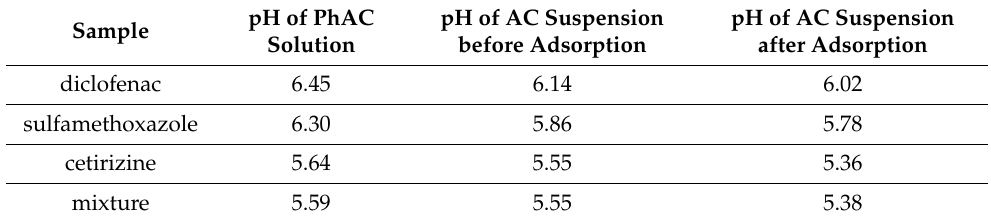
Table 3. pH values of PhACs solutions before and after adsorption using HWOH. SD = ± 2%.